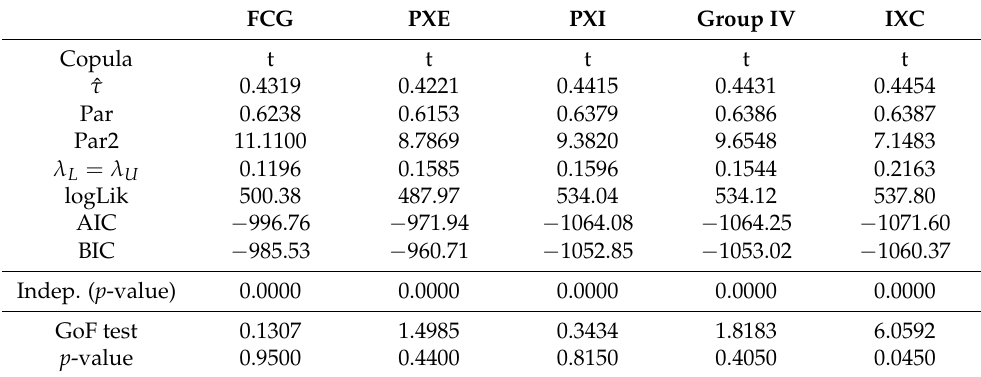
Table 4. Dependence structure for Brent crude oil and single